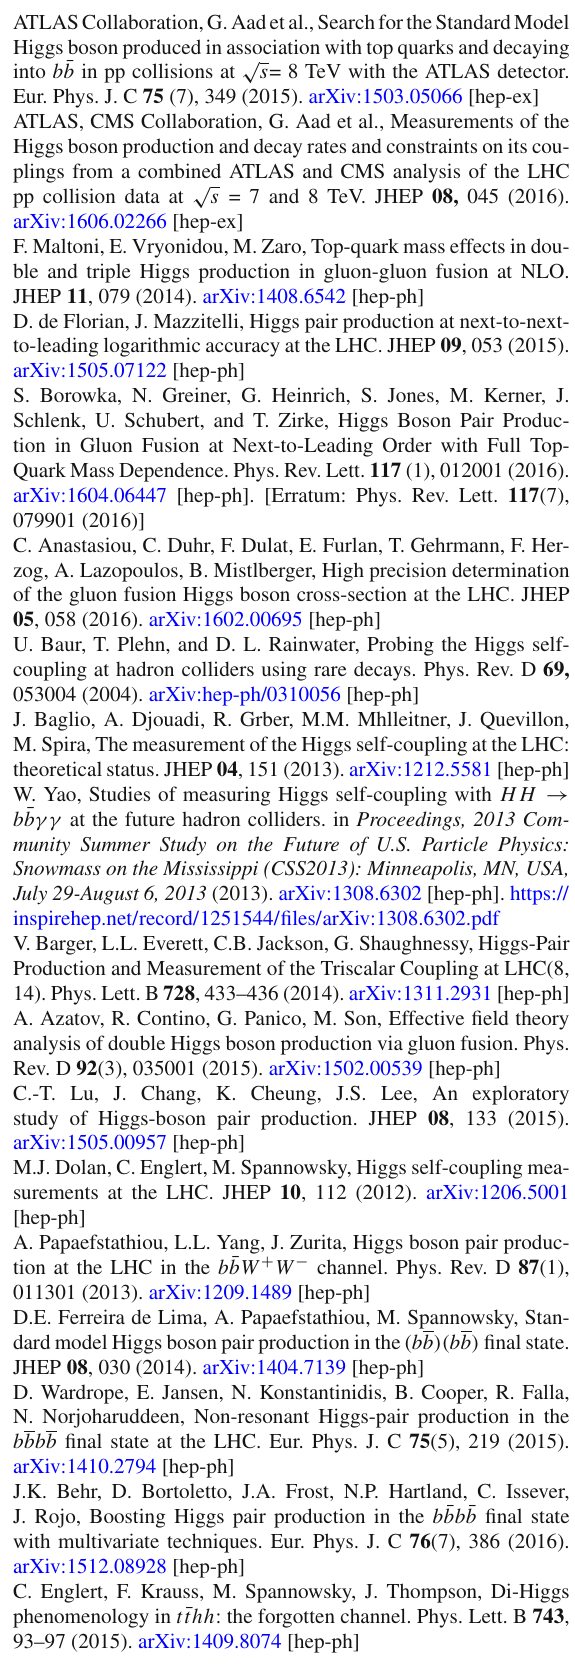
Table 4 Theoretical uncertainty for different production channels Production